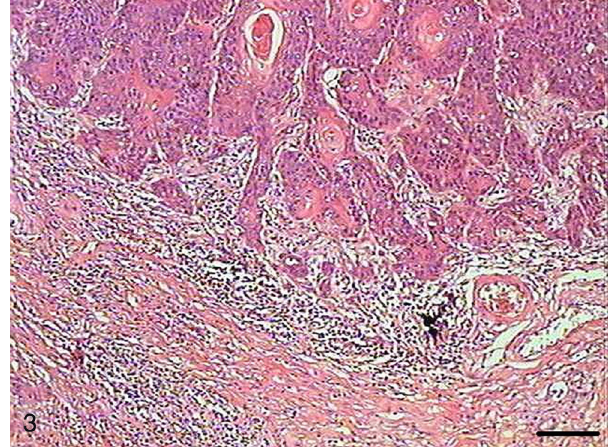
Figure 5 Grade III squamous carcinoma cells. Micrograph of grade III squamous carcinoma cells with apoptotic cells with nuclear hyperchromatacism (arrows) (HE, bar = 10 (cid:2) m).